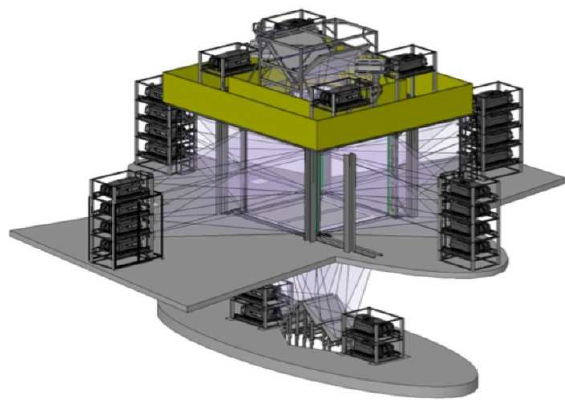
Figure 7. KAUST’s Cornea. Illustration: Mechdyne Corporation.